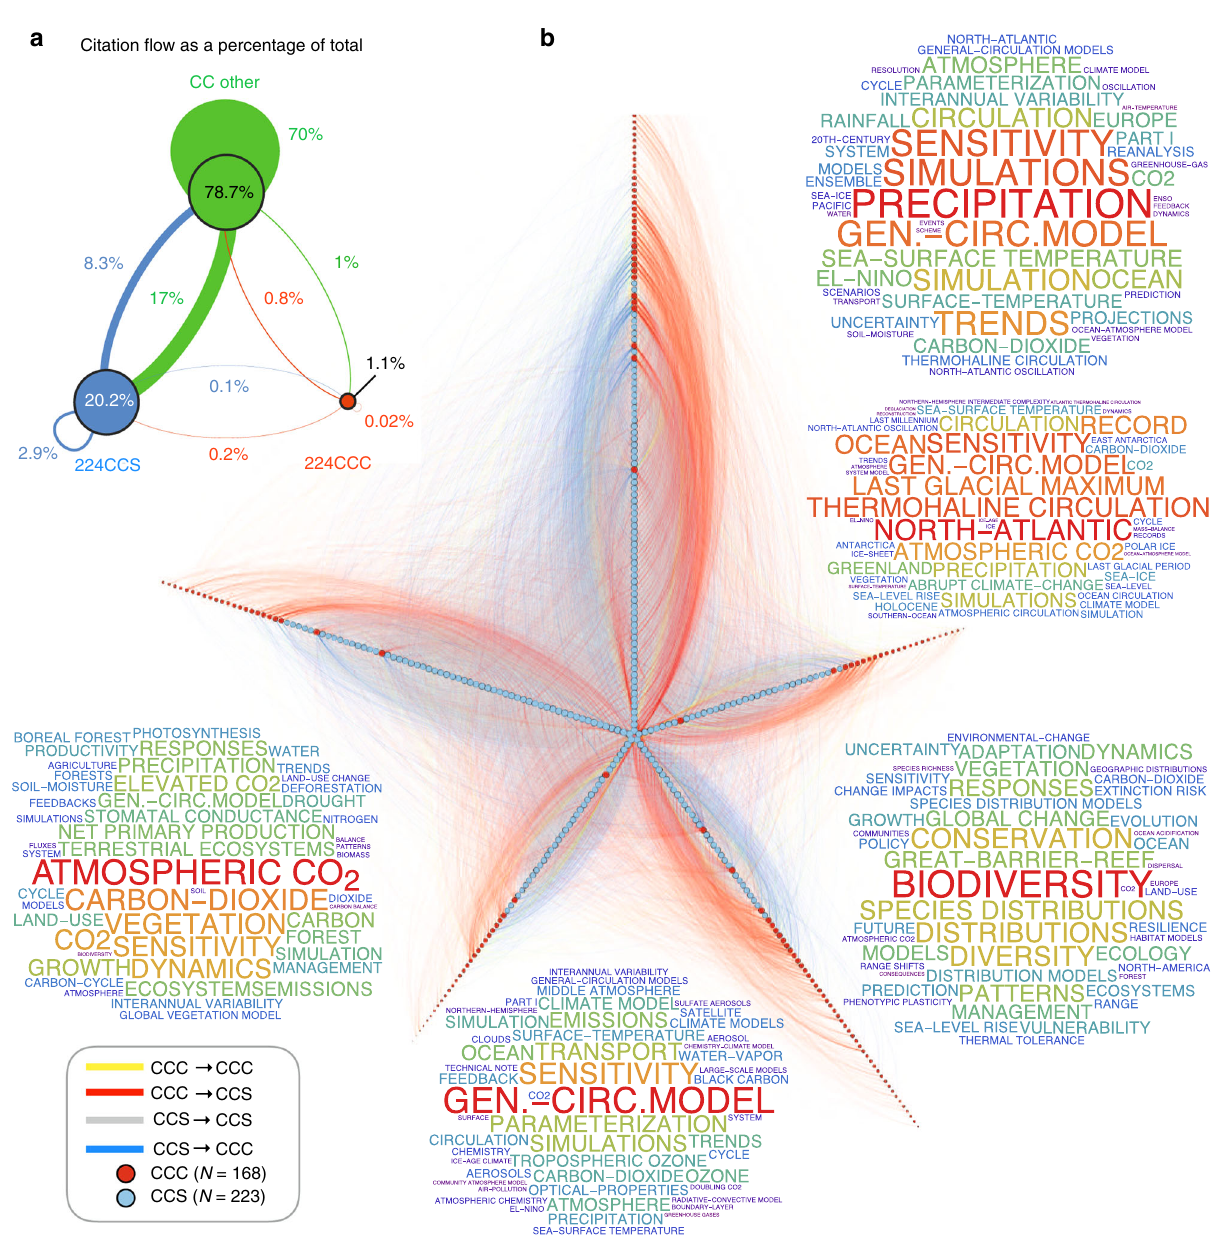
Fig. 7 Research article citation network — group and individual level. a Within-group and between-group citation fl ow as a percentage of the total number of citations produced across three researcher groups. Node size captures the net citation fl ow into a given group; link width is proportional to the fraction of the total citation fl ow, with link color indicating the source group. For example, 20.2% of the total citations are directed toward 224 climate change scientists (CCS) (corresponding to 0.44% of the total 50,442 researchers analyzed in the group-level citation analysis), whereas only 1.1% are directed toward the 224 published climate change contrarians (CCC); roughly 17 times as many citations fl ow from the CC Other to CCSs as from the CC Other to CCCs. b Nodes in the network are CCS and CCC researchers with at least one publication receiving at least one citation from another node (i.e., connected within the citation network); roughly 90% of the nodes are CCSs because 218 CCCs have no publications citing or cited by other publications within the set of publications by CCCs and CCSs. The links capture the total number of citations fl owing from publications authored by scientist i to the publications authored by scientist j and are colored according to the source node; gray links are de-emphasized using low opacity level. Node size is proportional to the log of the total edge weight (citations) entering a given node. We used the Louvain modularity-maximization method 48 to identify groups of nodes belonging to a particular community — i.e., groups of node that are more connected to other nodes within the cluster than without. These communities are plotted along each of the spines, with nodes ordered according their size, so that the most prominent individuals are located at the center. Each community contains several CCCs, located mostly at the peripheral (low-prominence) tips, with just a few exceptions. Word clouds show the 50 most frequent Web of Science publication keywords associated with each community; keyword size is proportional to the log